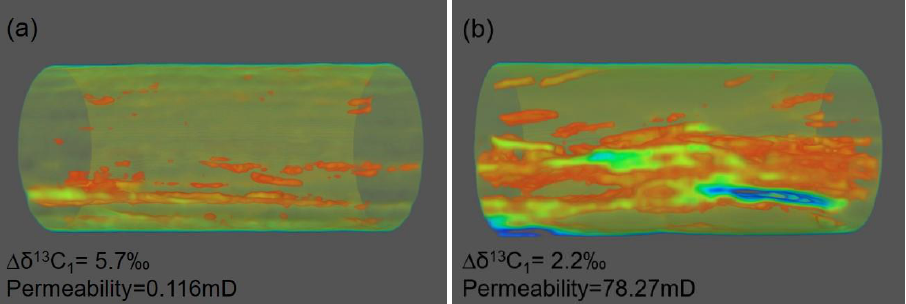
Figure 8. Comparison of fractures and microcrack development in sample JX30 ( a ) and sample JX52 ( b ) through X-ray computed tomography (CT). ( b ) through X-ray computed tomography (CT).